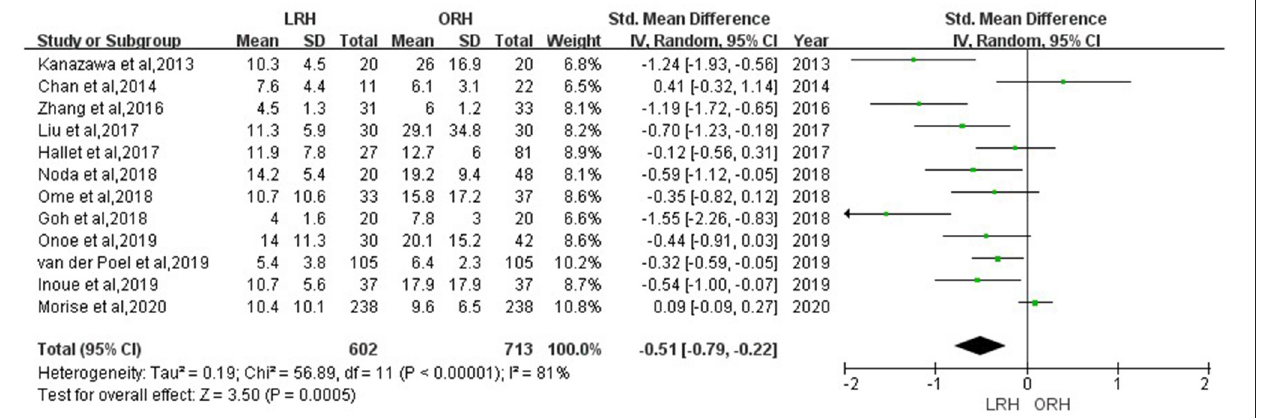
FIGURE 6 | Forest plots comparing hospital stay between LRH group and ORH group.